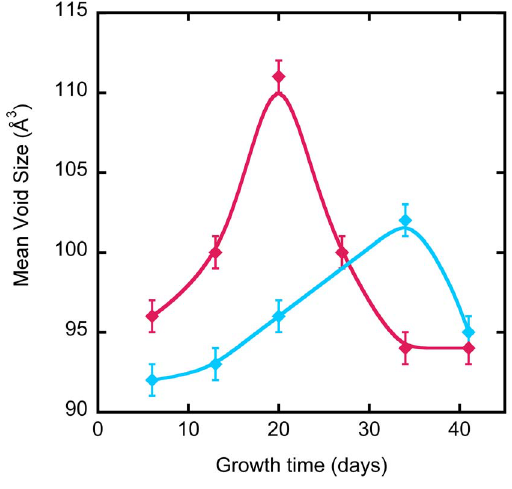
Figure 2. Growth time dependence of mean void volume in human colonic adenocarcinoma T84 3D cell cultures. The blue curve represents control cultures and the red curve represents cultures treated with TGF- b